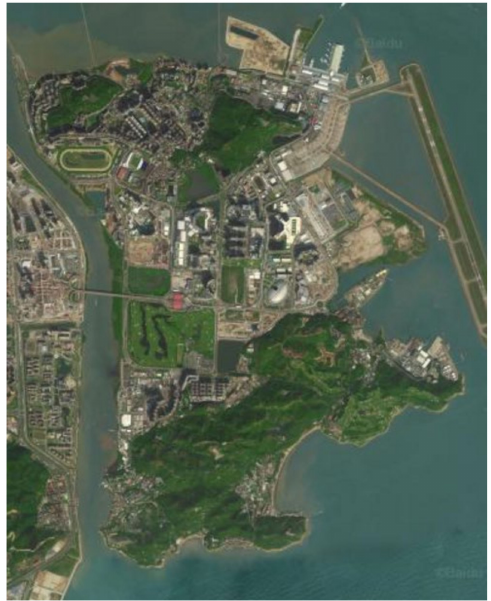
Figure 3. The Coloane-Taipa